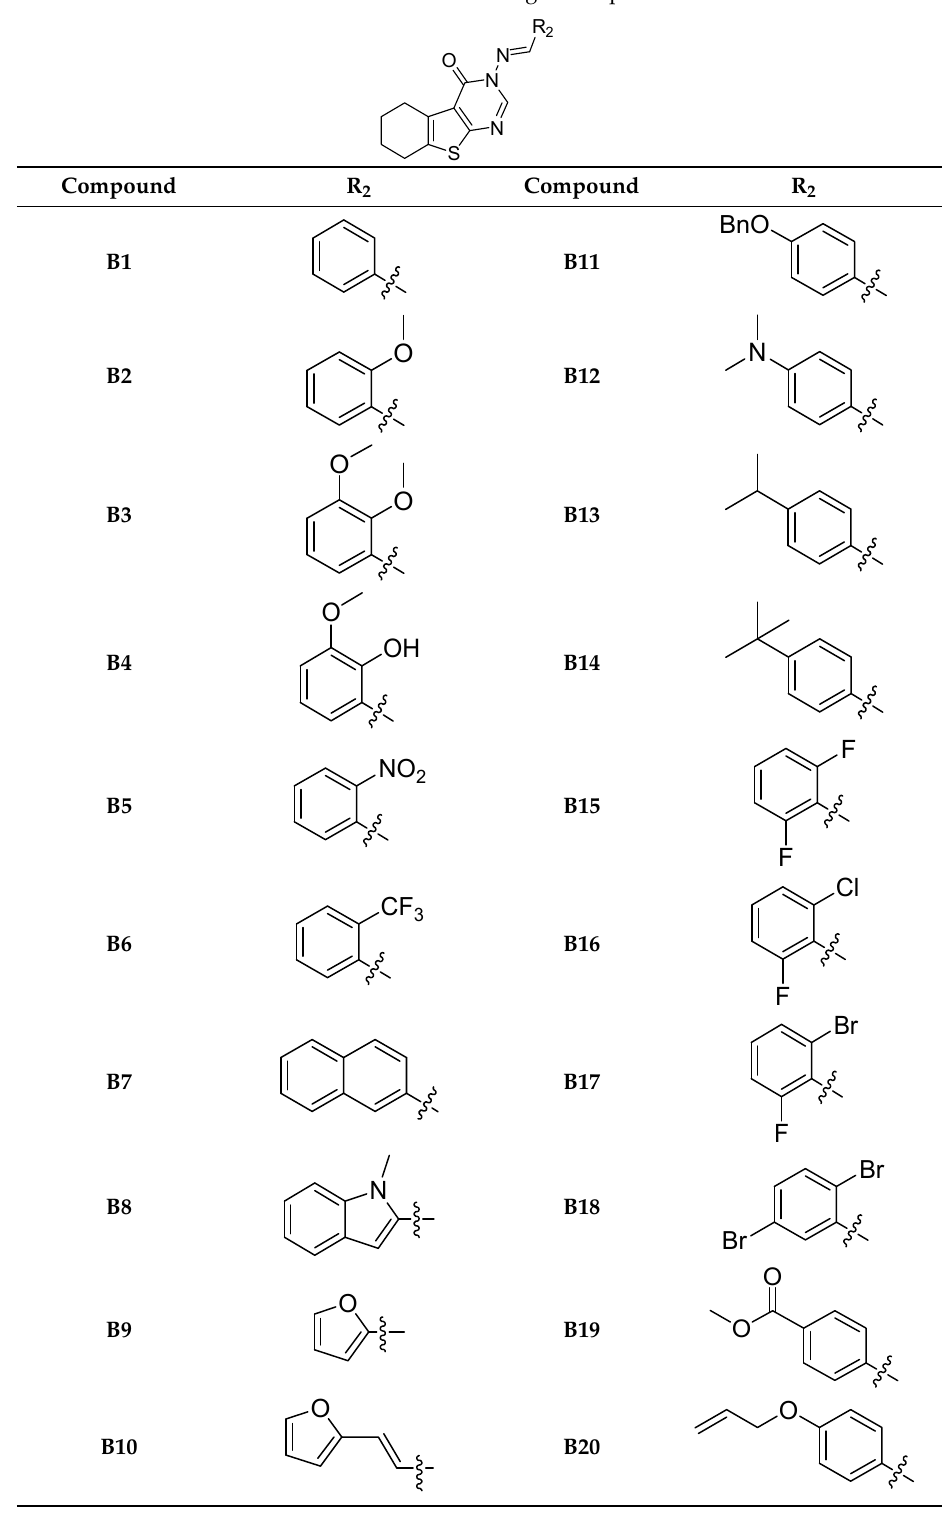
Table 2. Chemical Structures of Target Compounds B1 – 20 .